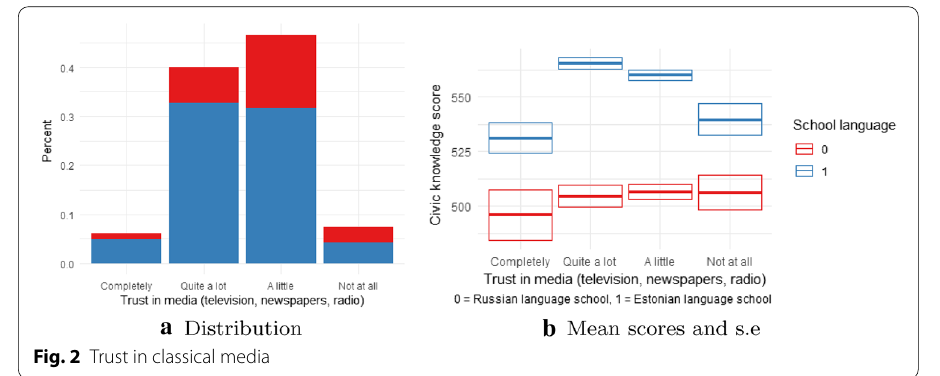
Fig. 2 Trust in classical media